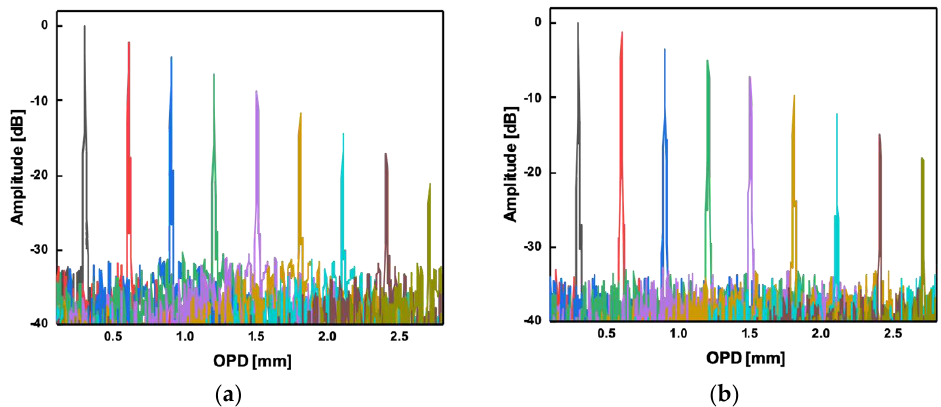
Figure 9. PSF measurement results according to OPD. PSFs obtained using ( a ) the S-ADL and ( b ) the S-TFL